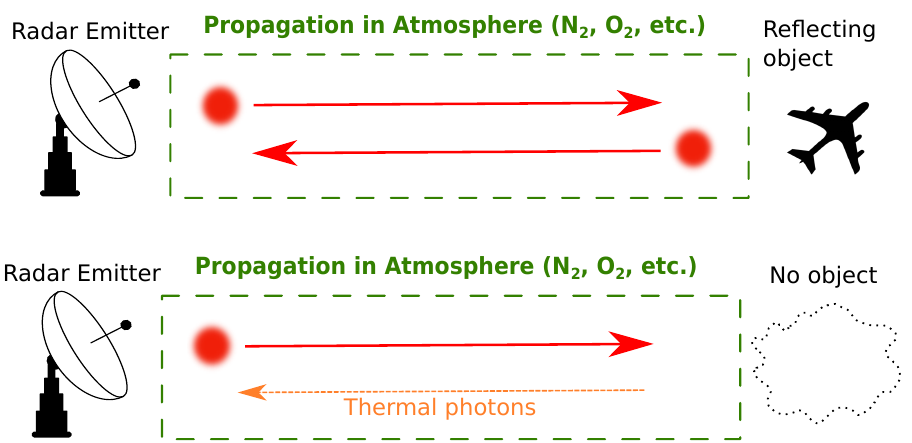
Figure 7. Detection strategies for the hypotheses H 0 and H 1 in Lloyd’s binary decision strategy for both single-photon and QI radars. When an object can be detected, we are in hypothesis H 1 . In hypothesis H 0 , only thermal photons can be detected, since no object is